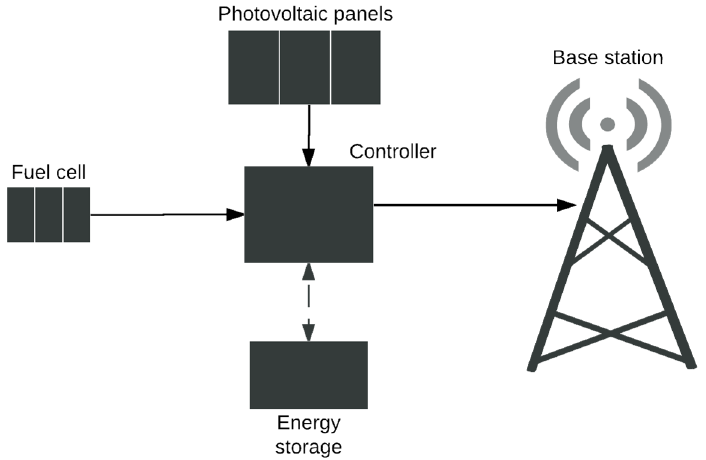
Figure 5. Typical configuration of a PV-fuel cell system in a base station